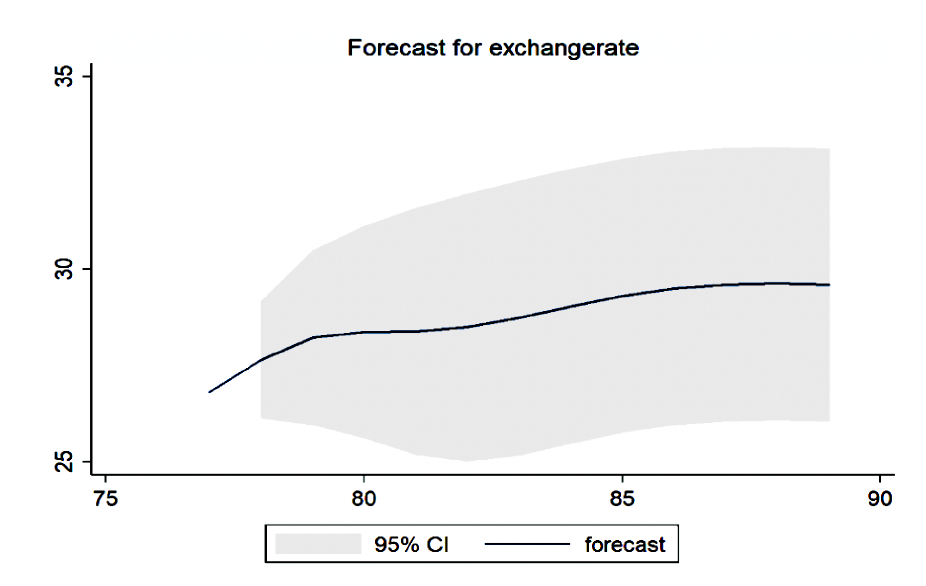
Figure 4. Current and forecast values of the USD/UAH exchange rate, calculated based on VAR (2)